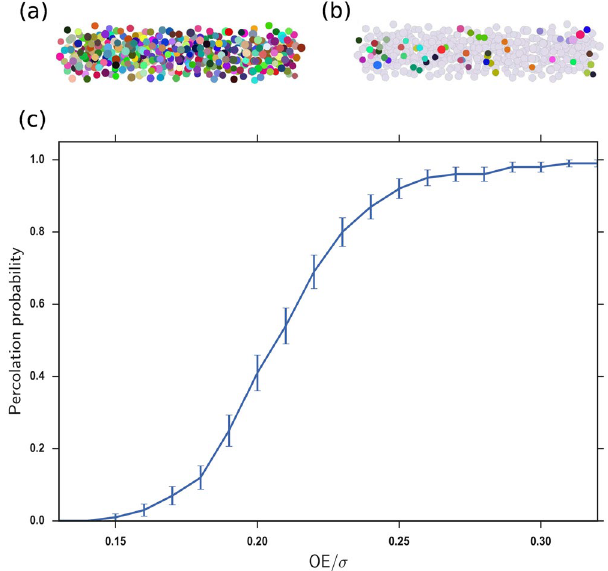
Figure 1. ( a ) A close-packed array of NPs with size disorder; ( b ) An NP array with a sample spanning metallic cluster; ( c ) The percolation probability of sample spanning metallic clusters as a function of OE / σ